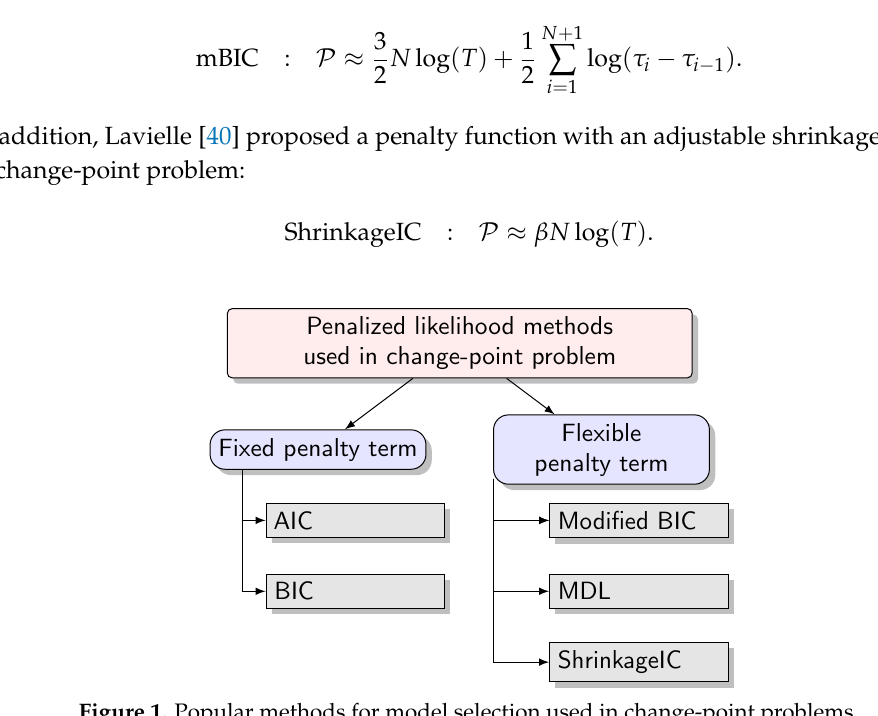
Figure 1. Popular methods for model selection used in change-point